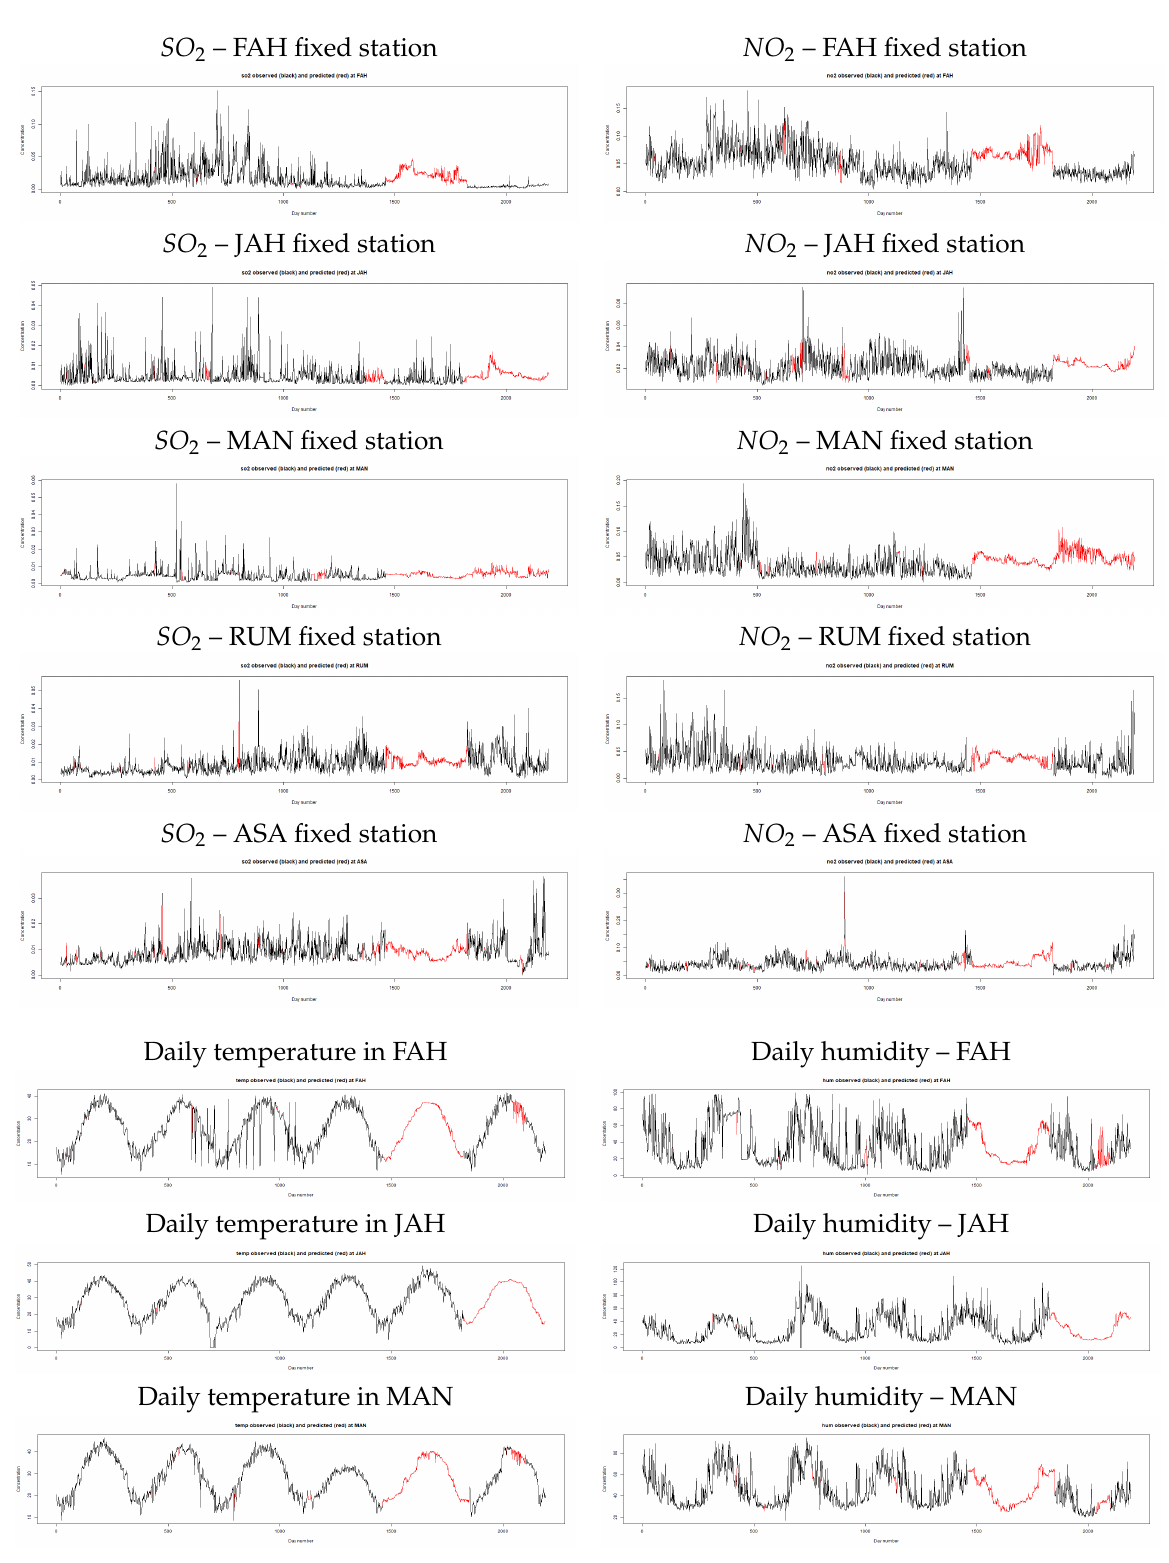
Figure 5. Daily concentrations of SO 2 , NO 2 , temperature, and relative humidity after estimating missing values using the missForest approach (from 2012–2017).